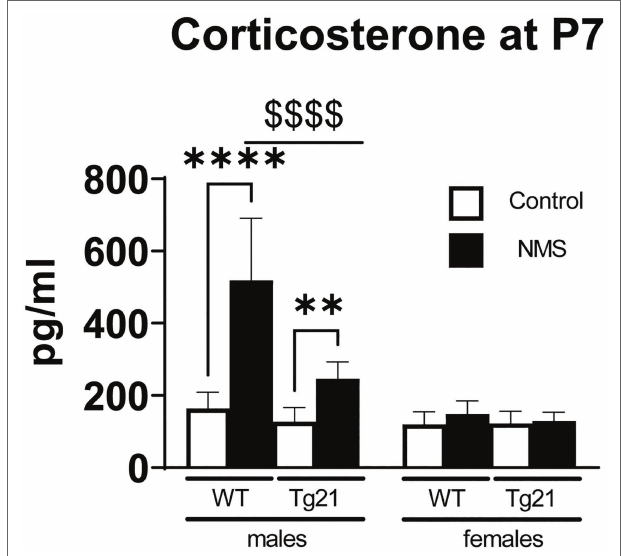
FIGURE 2 | Plasma concentration of CORT was evaluated at postnatal day 7 (P7) in WT (males n = 6; females n = 7) and Tg21 (males n = 8; females n = 6) mice exposed (or not – control) to NMS. Data reported as means ± SD. * Indicates differences between treatments (controls vs. NMS). $ Indicates differences between strains (WT vs. Tg21). ** : p < 0.01; **** , or $$$$: p < 0.0001.